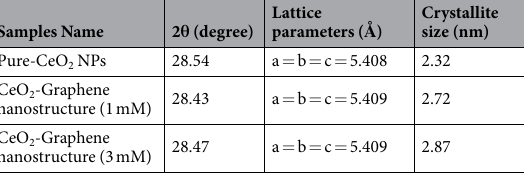
Table 1. Lattice parameters and crystallite size measured from the XRD patterns of pure-CeO 2 NPs, 1 mM and 3 mM CeO 2 -Graphene